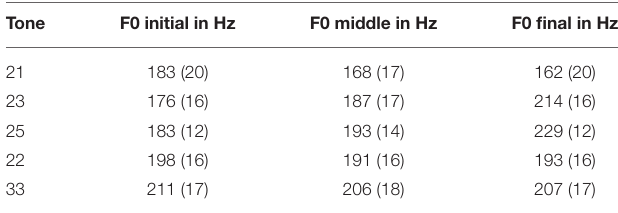
TABLE 2 | Results from the acoustic analysis of the different Cantonese lexical tones.